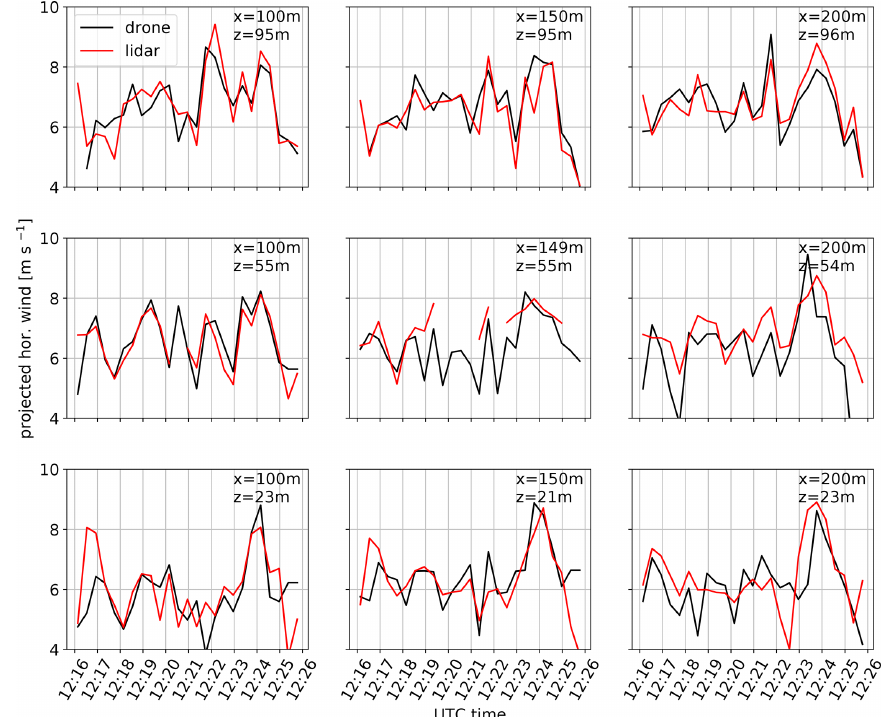
Figure 11. Time series of wind measurements of nine quadrotors compared to corresponding lidar measurements at the same locations on 24 July